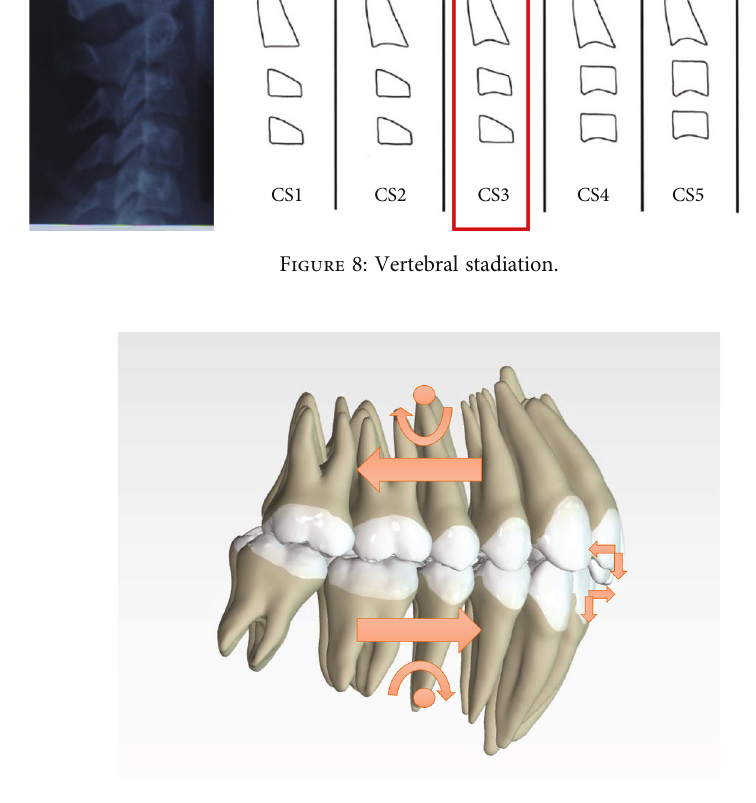
Figure 9: Herbst appliance force.